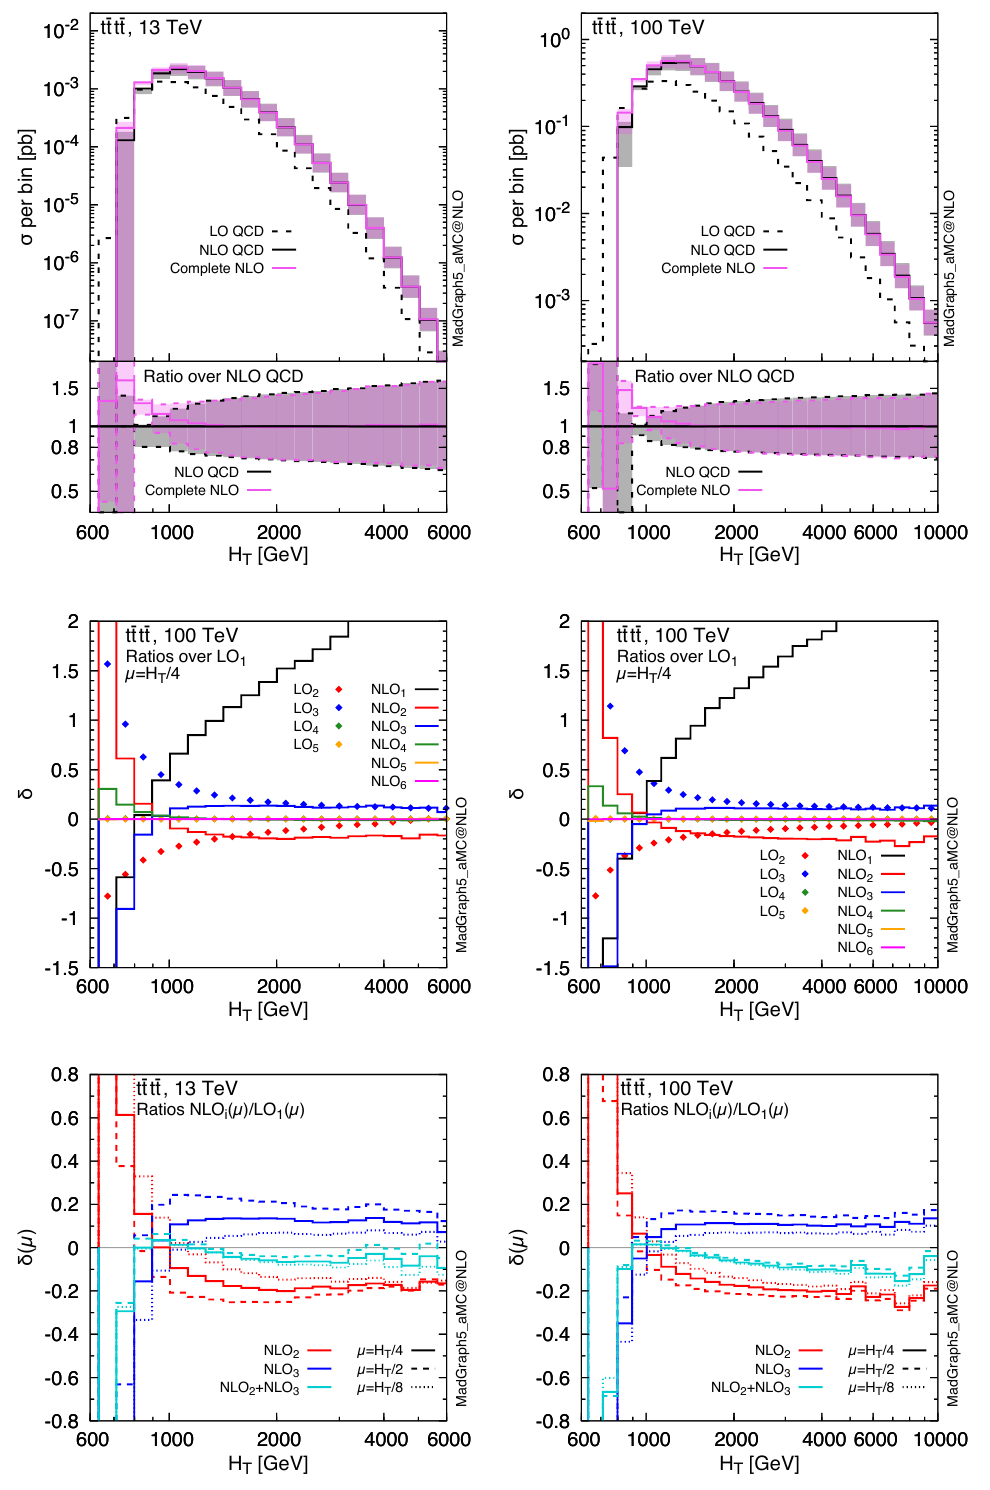
Figure 10 . The H T distribution in t (cid:22) tt (cid:22) t production. See the caption of (cid:12)gure 9 for the description of the plots.